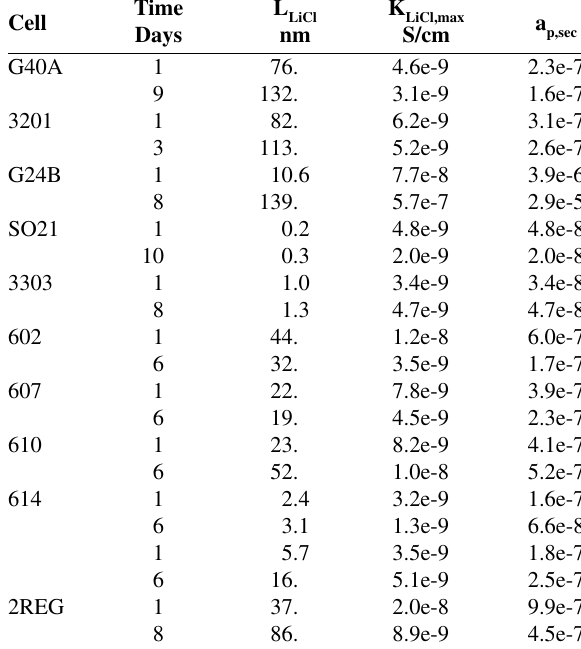
Table 6. Results derived from Q3-R4, the »secondary layer«, using circuit #1. The ratio of free to blocked area in the »secondary la- , is calculated using eq.(14). yer«, a p,sec